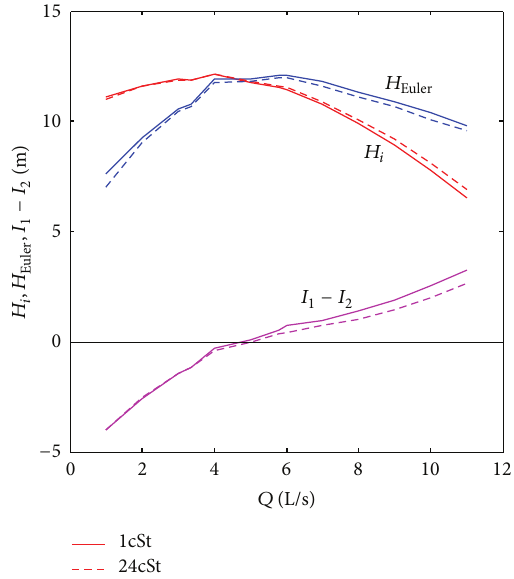
Figure 9: Euler head and total energy head developed in the impeller and rothalpy plotted as a function of flow rate at two viscosities of 1cSt and 24cSt as well as Ra = 50 𝜇 m.